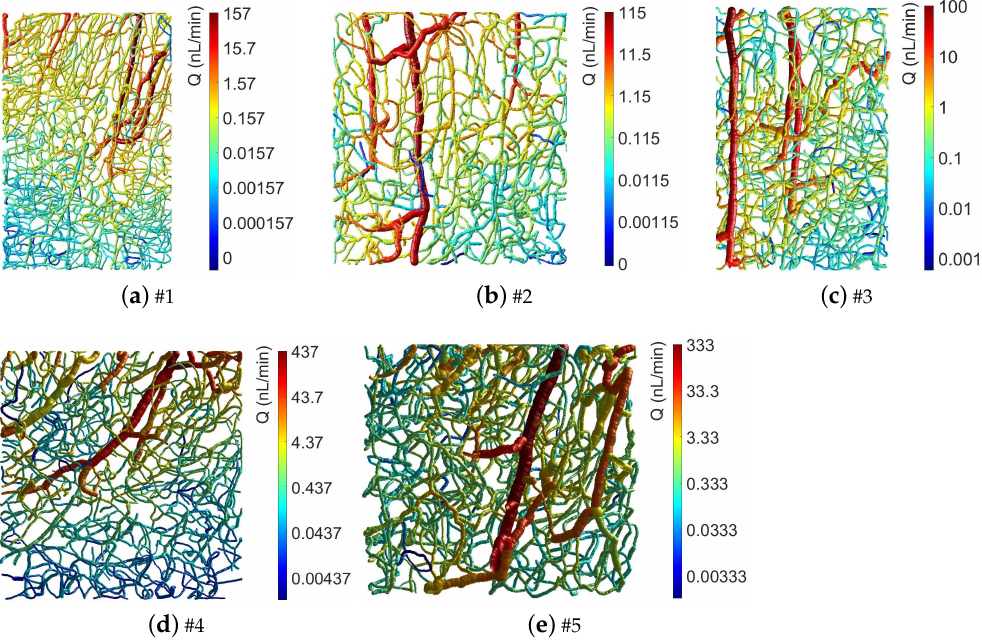
Figure 7. Computed blood flow (in [nL/min]) within the 5 cerebrovascular regions of the murine cortex. The heat map (in logarithmic scale) represents by colors the average blood flow distribution within the microcirculatory synthetic